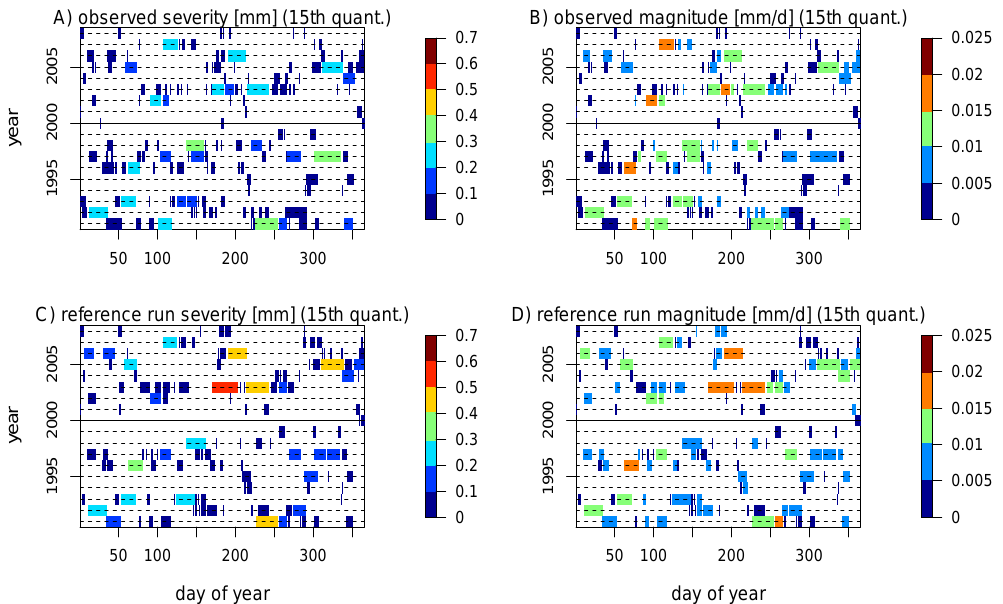
Fig. 7. Periods of streamflow drought occurrence, with severity ( A and C ) and magnitude ( B and D ) indicated by colors. (A) and (B) are derived from the observed runoff, while (C) and (D) are derived from the reference run